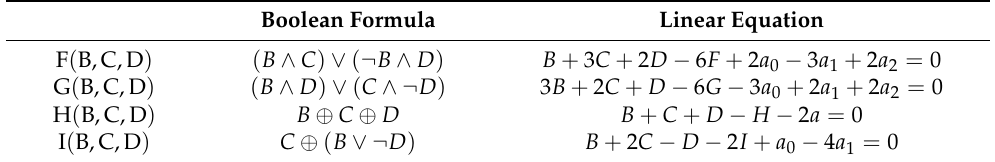
Table 2. Nonlinear functions in MD5 hash